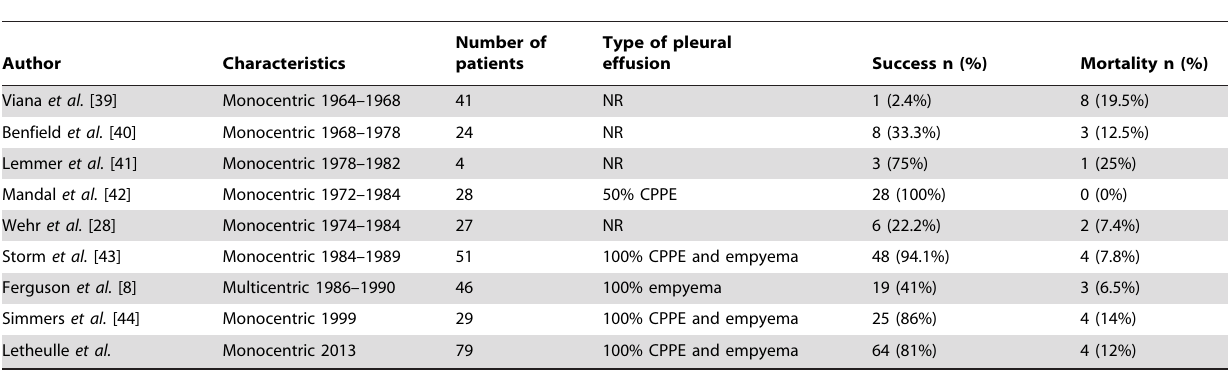
Table 6. Success rates of iterative therapeutic thoracentesis in clinical studies: a literature